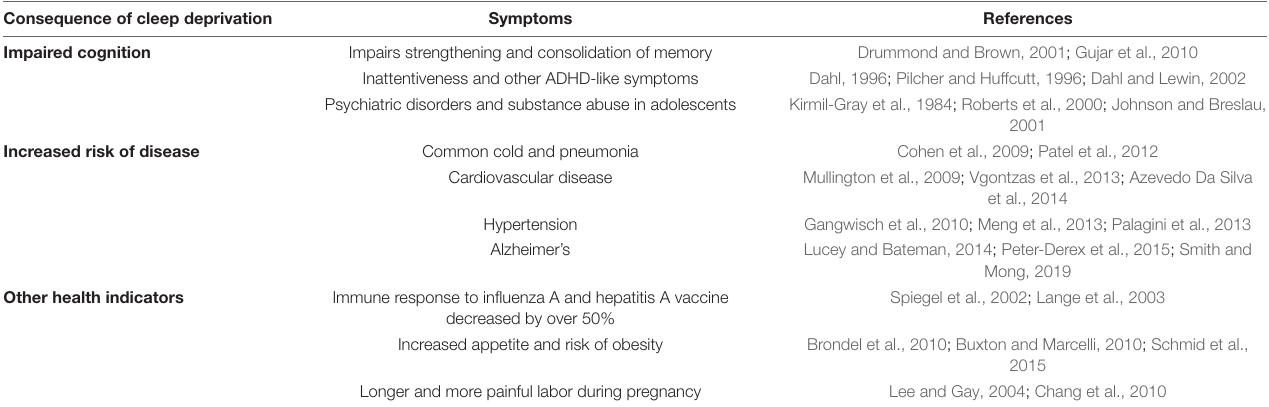
TABLE 1 | Sleep disruption has vast health